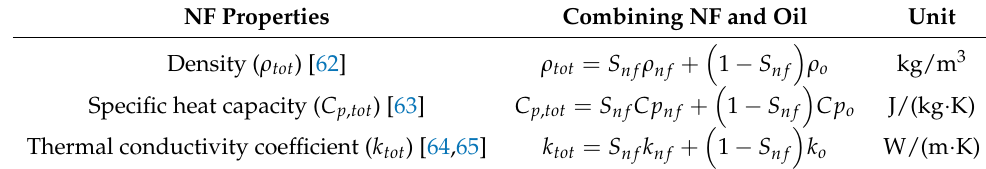
Table 5. Properties that were used in the energy